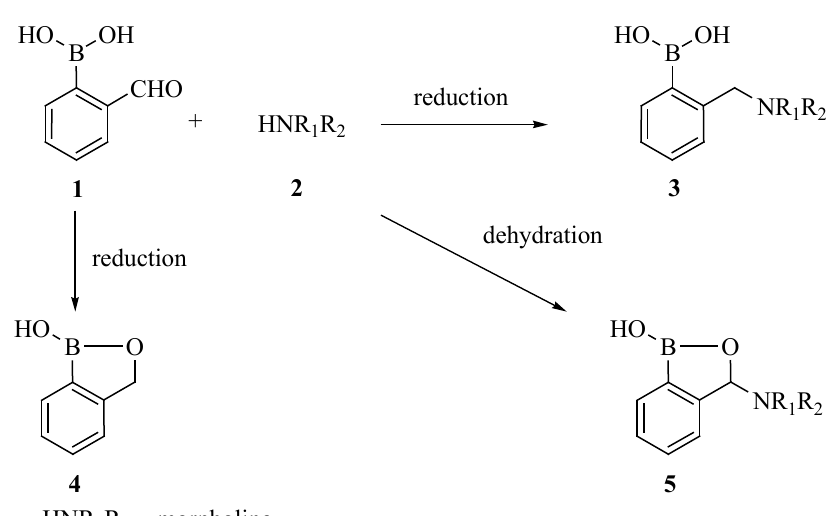
Scheme 1. Reactivity of 1 under amination-reduction